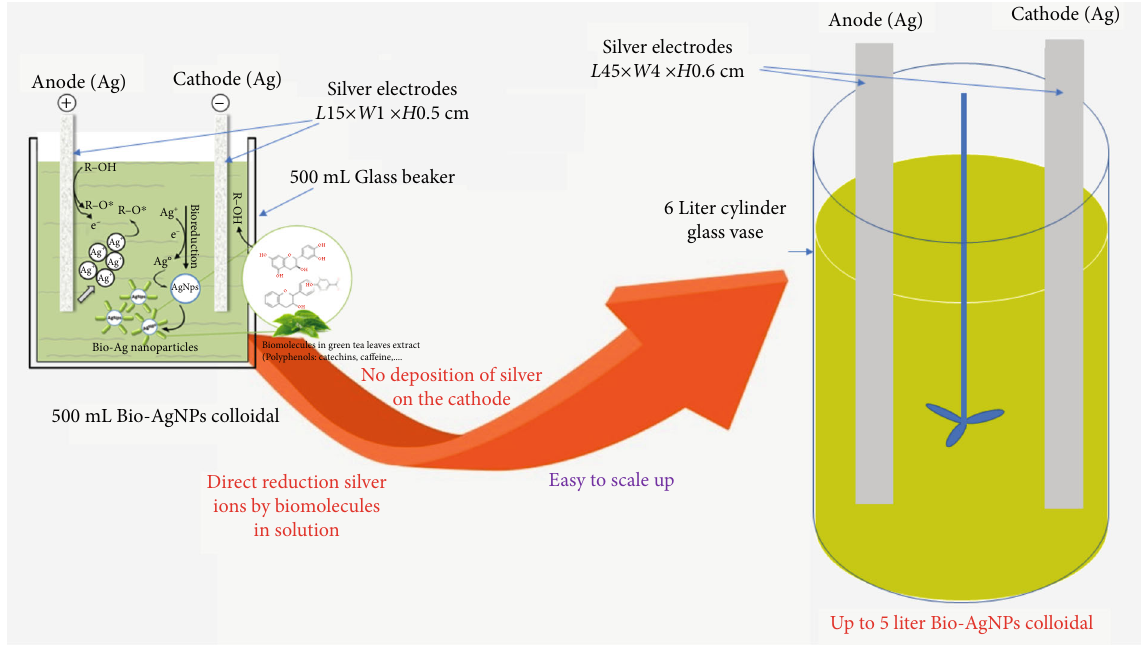
Figure 3: Schematic representation of the biogenic AgNPs ’ scale-up generation mechanism by using both electrochemical process and GTE as the reducing